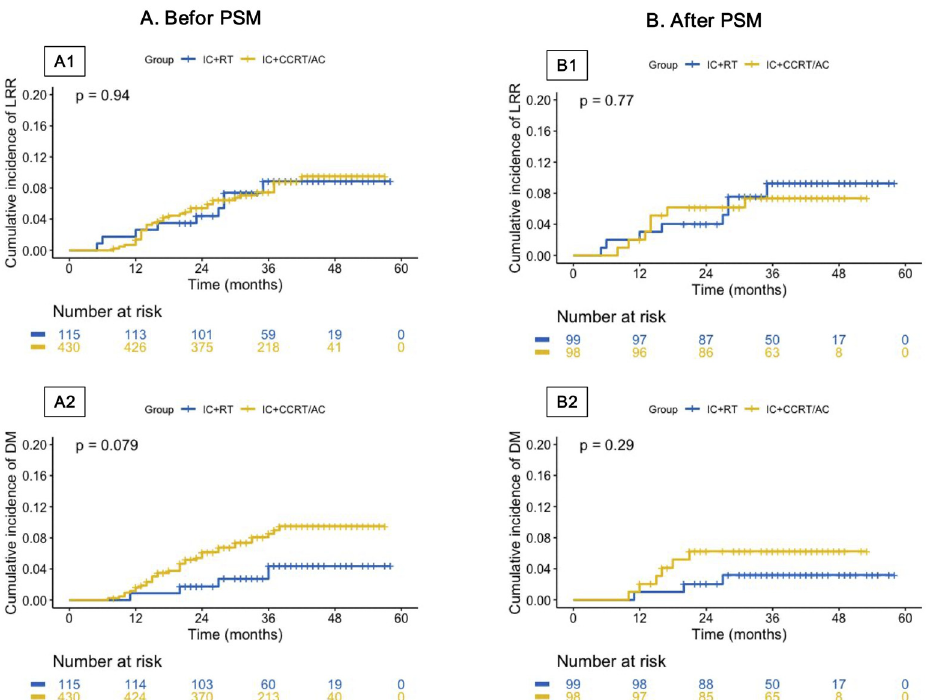
Figure 3. Cumulative incidence of locoregional relapse (LRR, ( A1 , B1 )) and distant metastasis (DM, ( A2 , B2 )) among patients who underwent IC + RT and IC + CCRT/AC. ( A ) Before propensity score matching analysis. ( B ) After propensity score matching analysis. Abbreviations: PSM, propensity score matching; LRR, locoregional relapse; DMFS, distant metastasis; IC, induction chemotherapy; RT, radiotherapy; CCRT, concurrent chemoradiotherapy; AC, adjuvant chemotherapy.